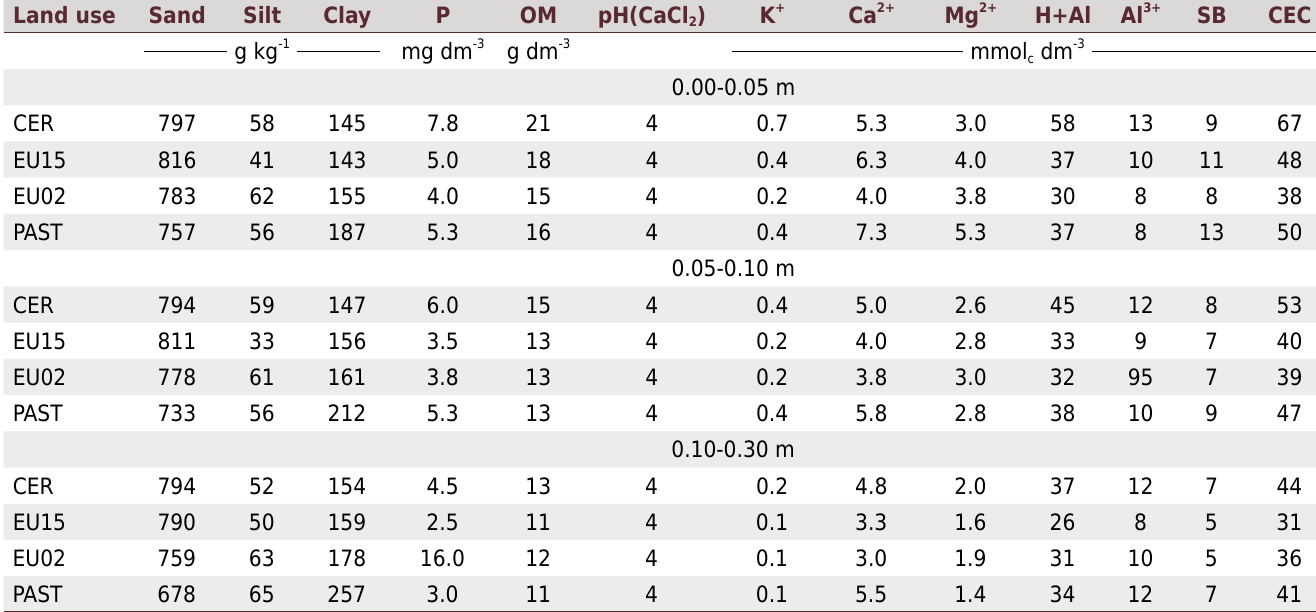
Table 1. Physical and chemical characterization in four land uses (preserved Cerrado - CER, 15-year-old Eucalyptus - EU15, 2 year-old Eucalyptus - EU02, and Pasture - PAST) and soil layers Land use Sand